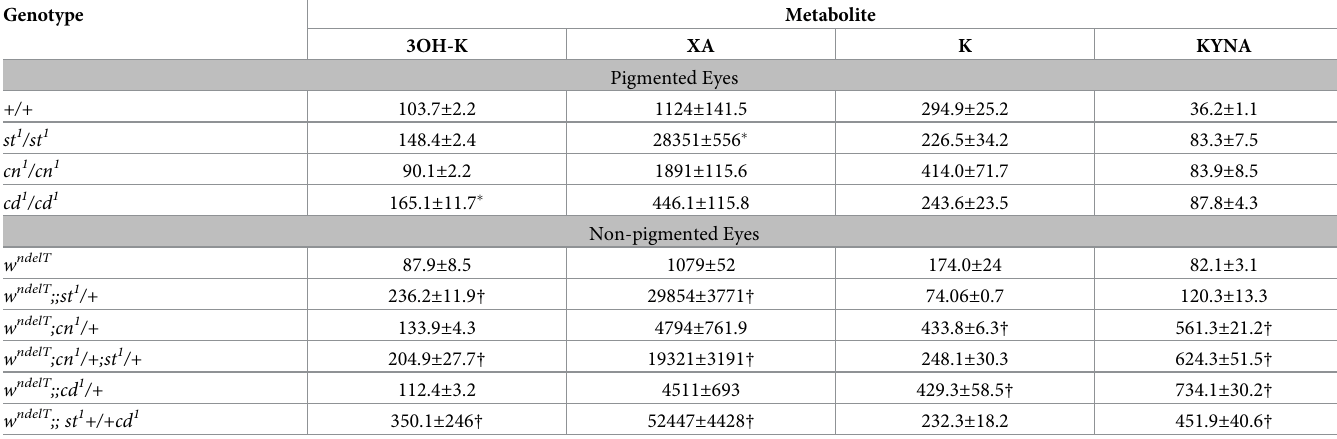
Table 1. Metabolite abundance across genotypes.